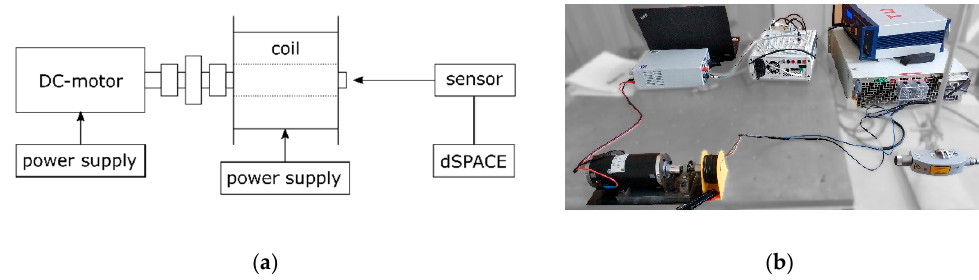
Figure 7. ( a ) Schematic of the measurement setup of the test stand and ( b ) real system.